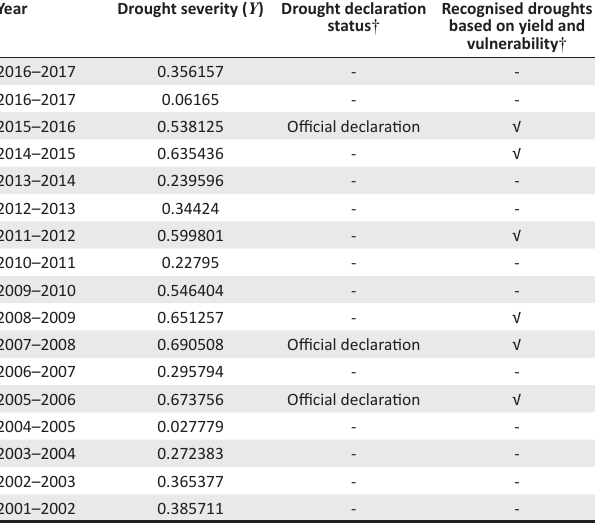
NDVI, Normalised Difference Vegetation TABLE 5: Drought trigger threshold determination.